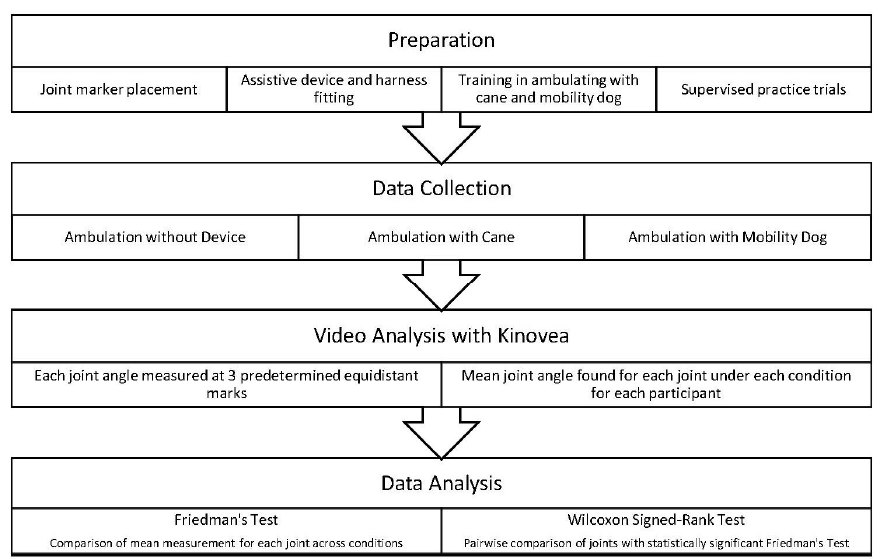
Figure 1. Diagram of study design.